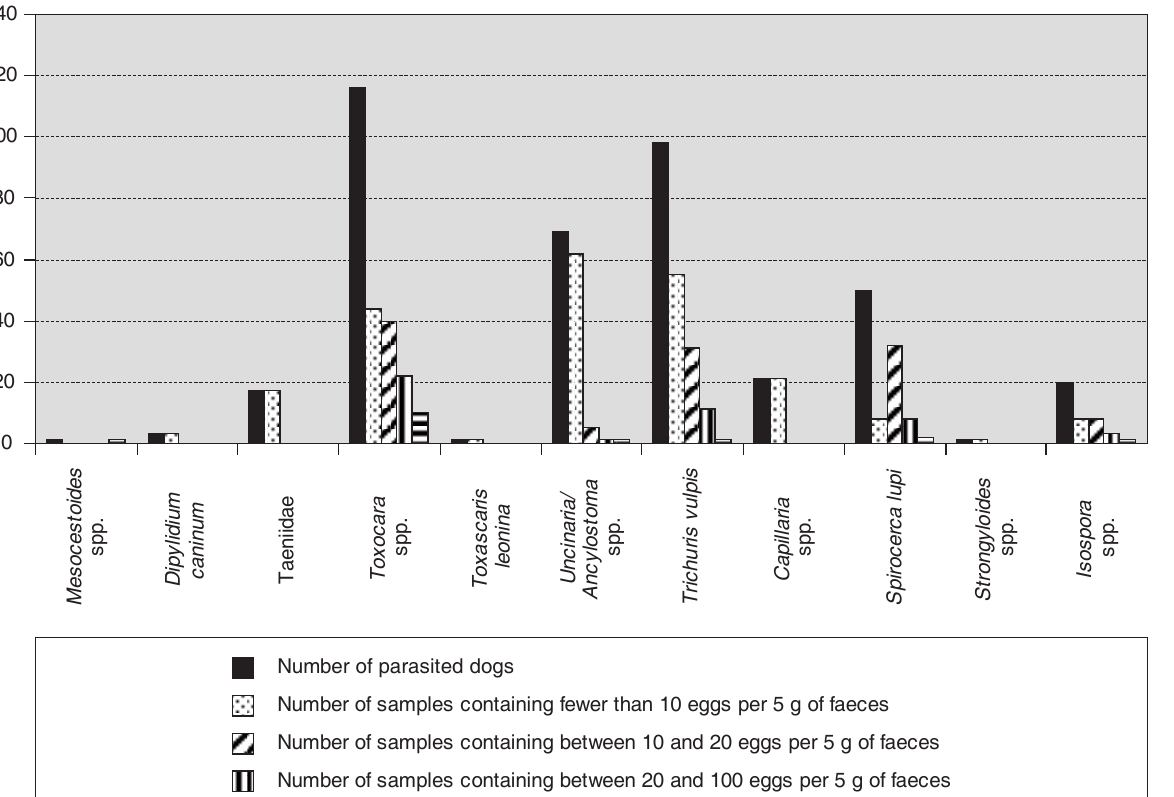
Number of parasited dogs Number of samples containing fewer than 10 eggs per 5 g of faeces Number of samples containing between 10 and 20 eggs per 5 g of faeces Number of samples containing between 20 and 100 eggs per 5 g of faeces Number of samples containing more than 100 eggs per 5 g of faeces Results of coproscopies conducted in 198